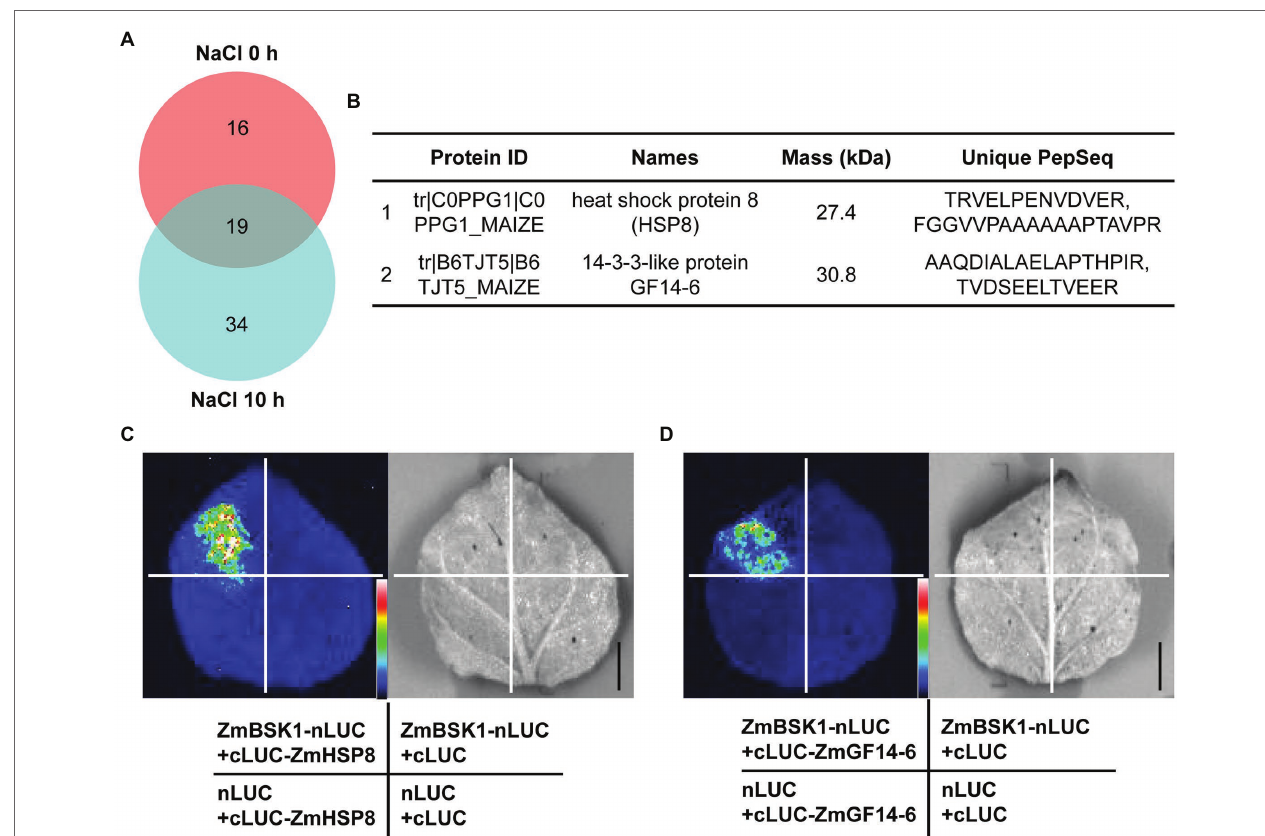
FIGURE 6 | ZmBSK1 interacts with its target proteins ZmHSP8 and ZmGF14-6. (A) Venn diagram shows the number of ZmBSK1-interacting proteins in OE- ZmBSK1 maize plants with or without salt stress. About 10-day-old maize seedlings were treated with 200 mM NaCl for 0 or 10 h. Total proteins extracted from leaves were immunoprecipitated by anti-Flag antibody and the interacting proteins of ZmBSK1 were identified by immunoprecipitation-mass spectrometry (IP-MS). (B) The candidate target proteins of ZmBSK1 upon mass spectrometry analysis only after salt treatment. Firefly luciferase complementation imaging (LCI) assays confirm the interactions of ZmBSK1 with ZmHSP8 (C) and ZmGF14-6 (D) . The combinations of ZmBSK1-nLUC and cLUC-ZmHSP8 , ZmBSK1-nLUC and cLUC- ZmGF14-6 were co-transformed into tobacco leaves. The combinations of ZmBSK1-nLUC and cLUC , nLUC and cLUC-ZmHSP8 , nLUC and cLUC-ZmGF14-6 , nLUC and cLUC were used as negative controls. nLUC and cLUC represent the N-terminal and C-terminal fragments of firefly luciferase, respectively. Images were collected from the detached leaves after infiltration for 3 days. Scale bar = 1